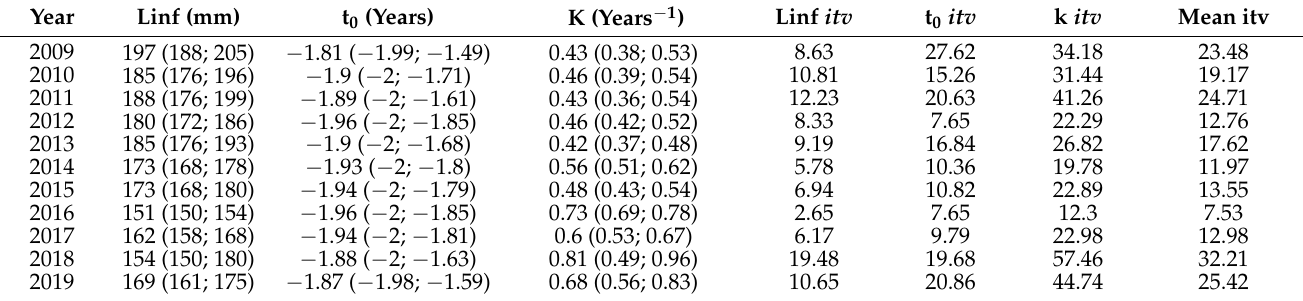
Figure 6. Length-age comparison plot of areas along an east-west longitudinal gradient from the otolith-based literature selection and current study results: Black Sea [35]; North Aegean Sea [36]; North and South Tunisia [37]; South of Sicily males and females (present study); Gulf of Lyon, Catalunya, Valencia, Alicante, Gulf of Vera Alboran Sea [36]; Bay of Biscay Eastern Atlantic [38]. * The values from Black Sea and Tunisian waters were converted from fork to total length (TL) for comparison purposes, using the total vs. fork length linear relationship obtained by present study data (TL = 1.1502 × fork length + 3.3413; r 2 = 0.98). The years with higher itv and higher sampling gaps (2011, 2018 and 2019) were excluded from the overall fitting of the Bayesian growth model (Table 5), as well as those years (2016 and 2017) characterized by a reduced age range (i.e., no Age 3; Table 4). Table 5. VBG Bayesian approach parameter estimates by year. The upper quartile of the Bayesian credibility intervals (2.5%; 97.5%) to the mean estimate ratio, expressed in percentage ( itv%